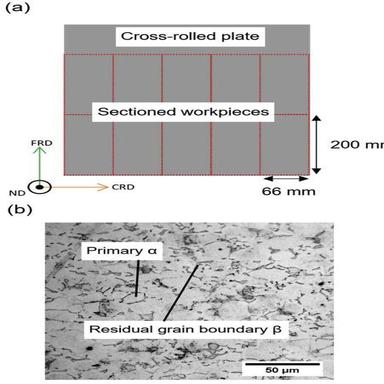
Schematic of the workpieces obtained from a cross-rolled plate (a) and a cross-sectional micrograph of the as-received material (b).